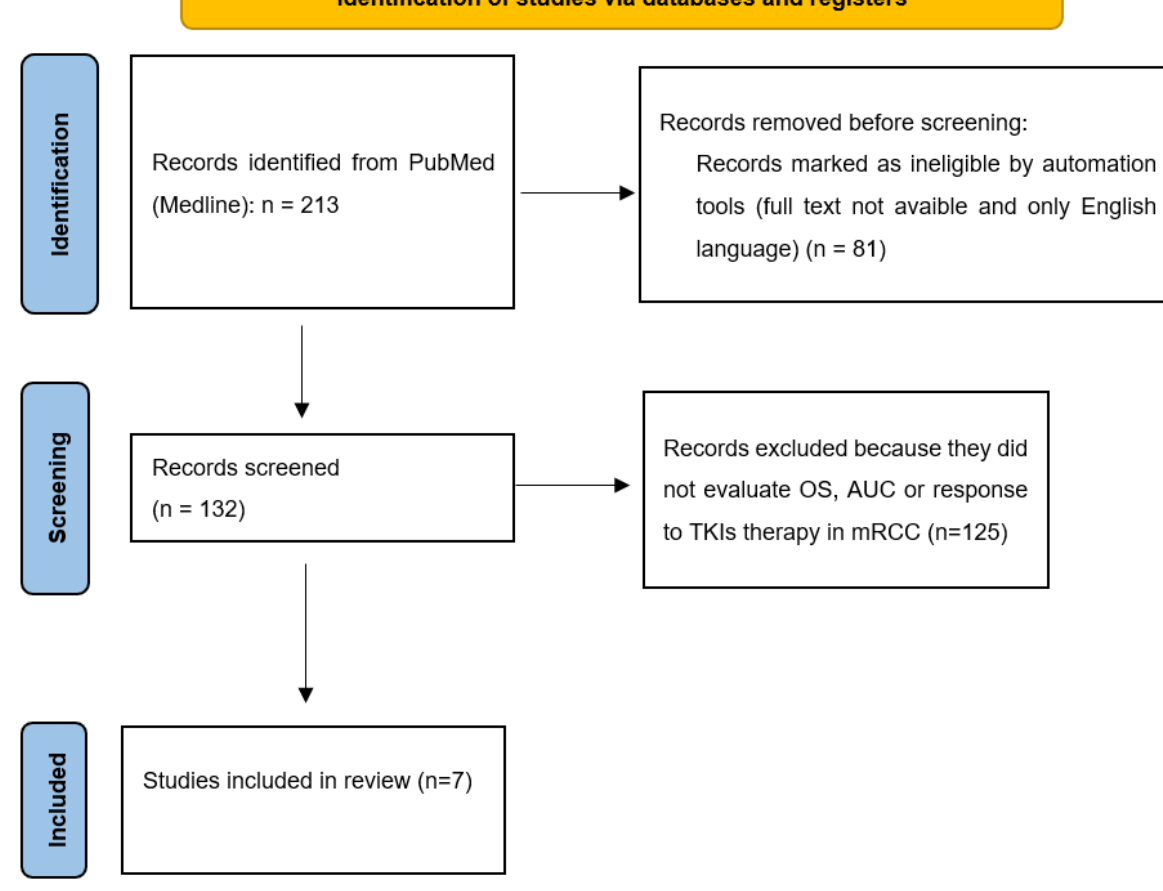
Figure 1. The PRISMA flowchart graphically depicts the selection of the study flow.